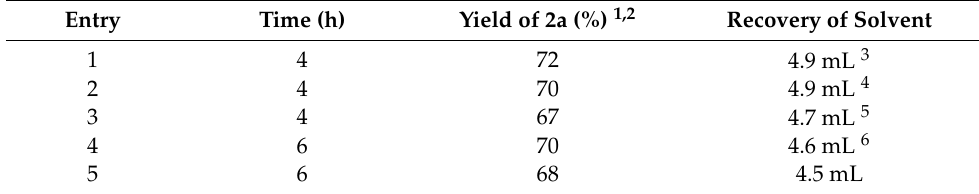
Table 4. Recovery and reuse of solvent system Gly/KBr 6:1.